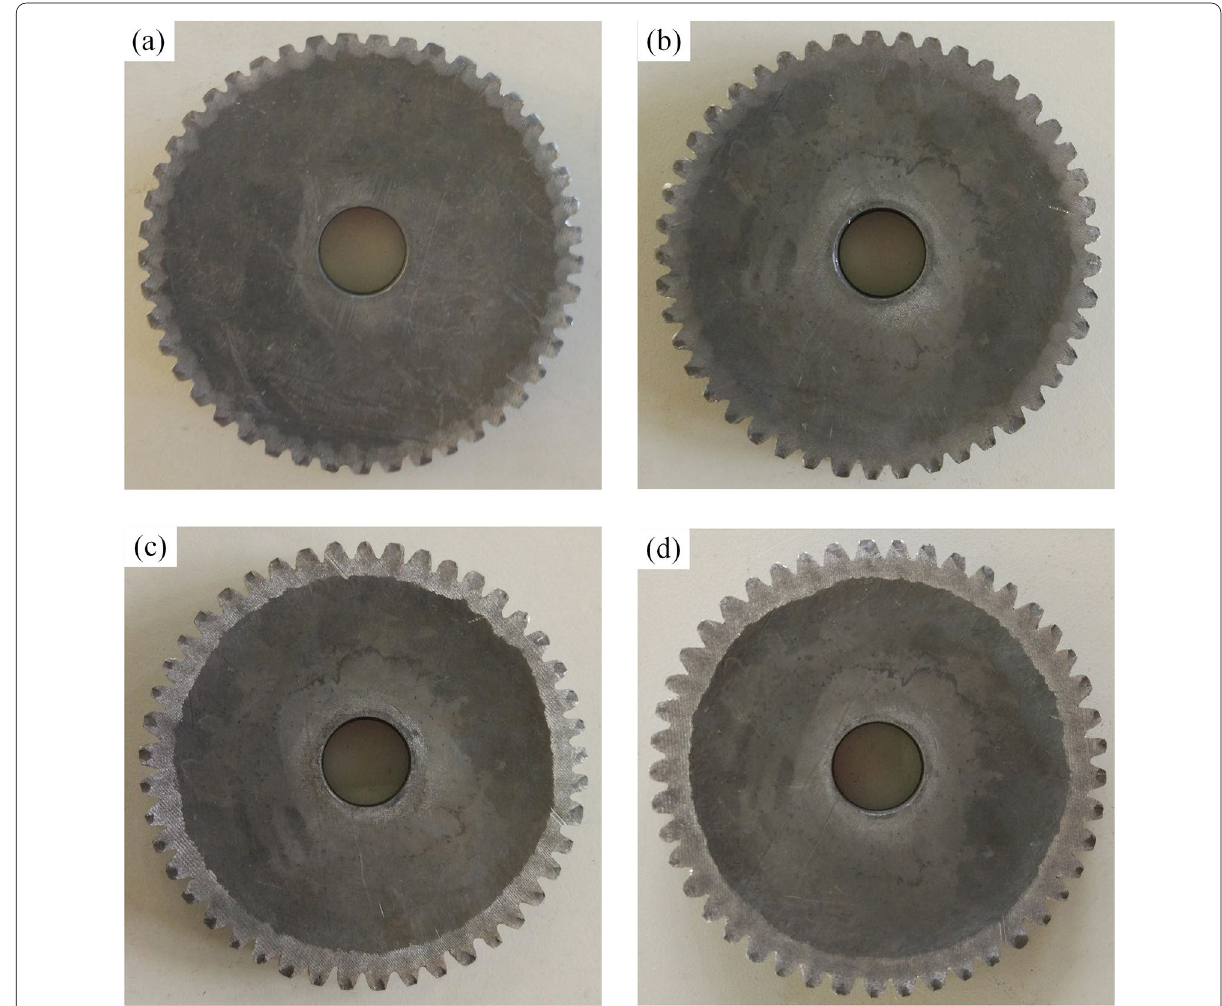
Figure 14 Lead sample’s forming results of each pass: (a) pass 1, (b) pass 2, (c) pass 3 and (d) pass 4